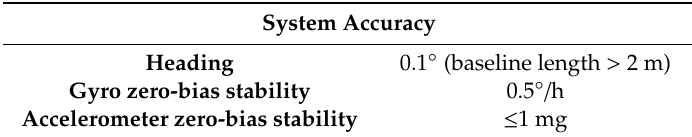
Table 4. System accuracy of XW-ADU7612.